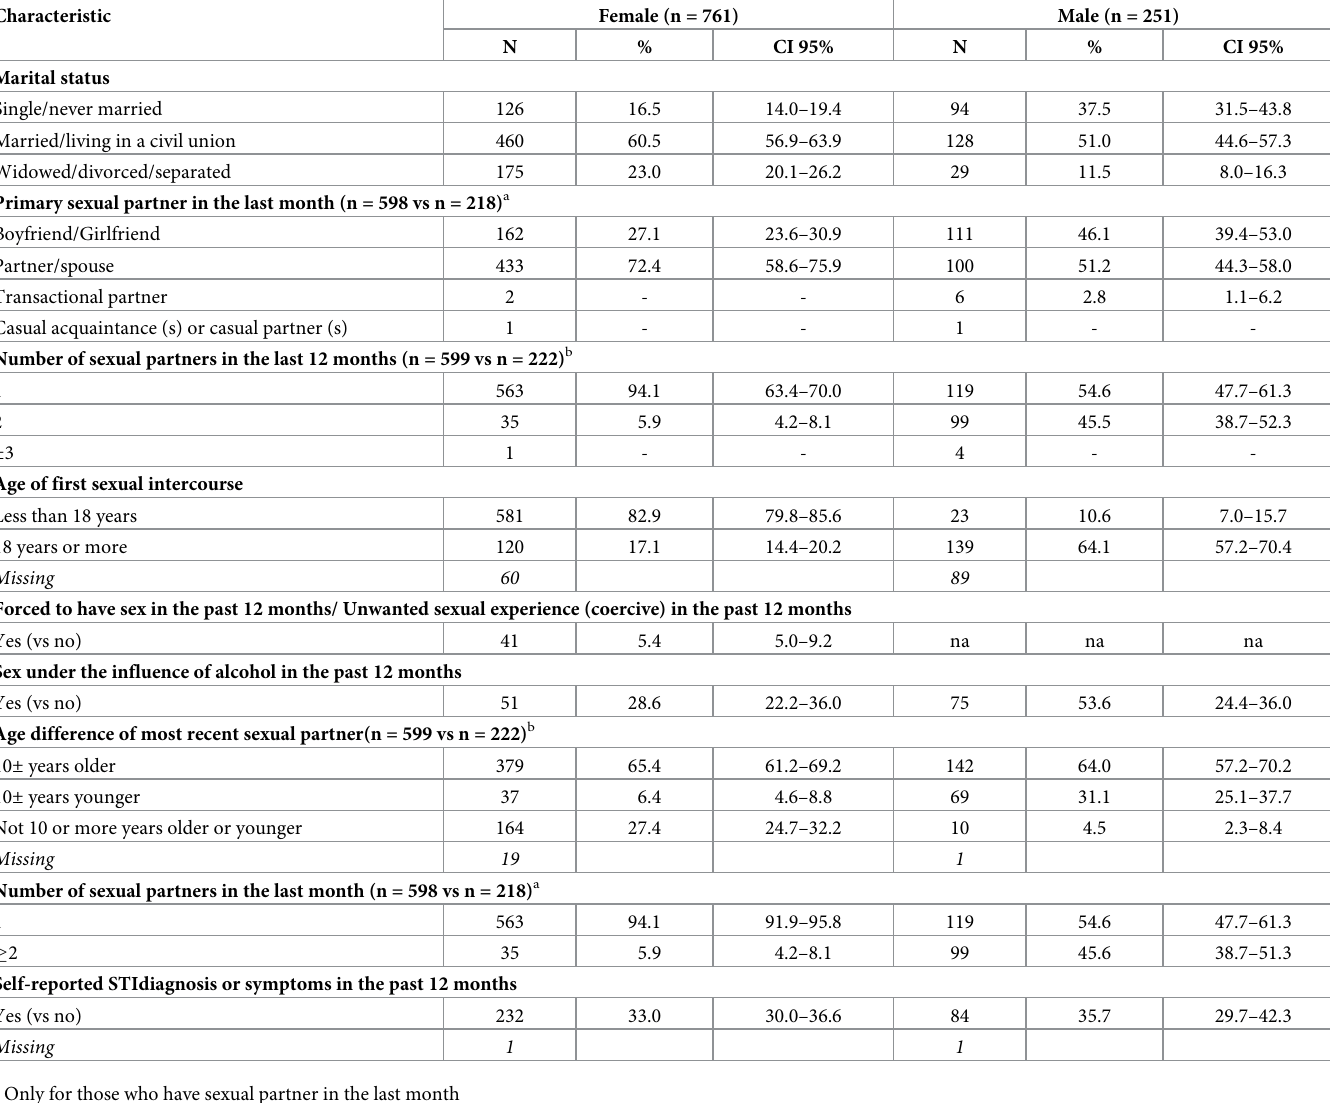
Table 2. Marital status and sexual risk behaviours among sexually active participants in miners community of origin, Gaza Province, Southern of Mozambique, 2017(N = 1012). Characteristic Female (n =